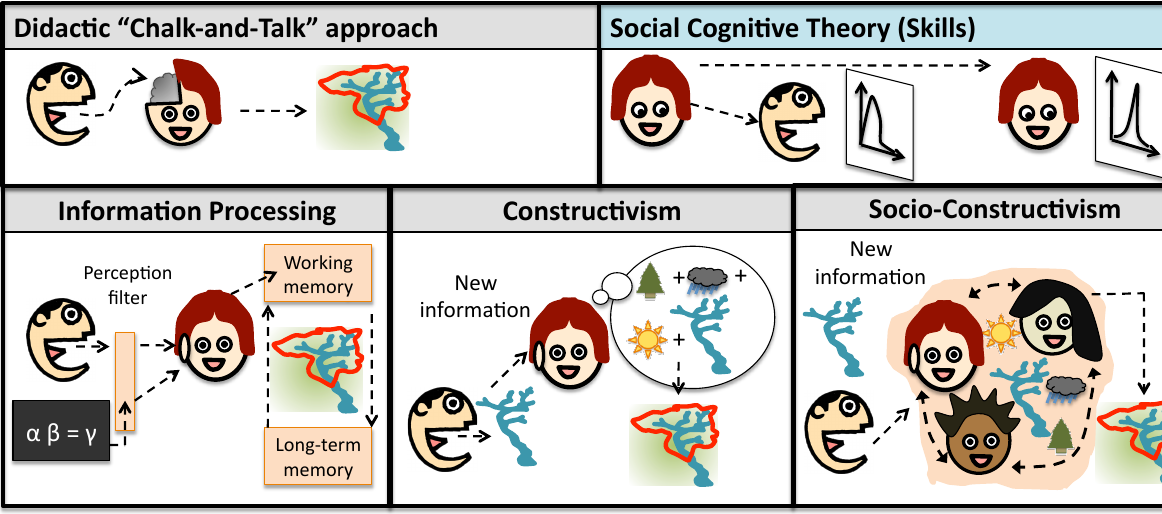
Fig. 2. Cartoon illustration of the major categories of learning theory in contrast with the assumptions implicit in a didactic or “chalk-and- talk” approach to teaching. Information processing accounts for the challenges associated with communication in a learning context. Students unconsciously filter the sensory inputs from ears and eyes, so that what the students “hear” is not necessarily what the instructor said.